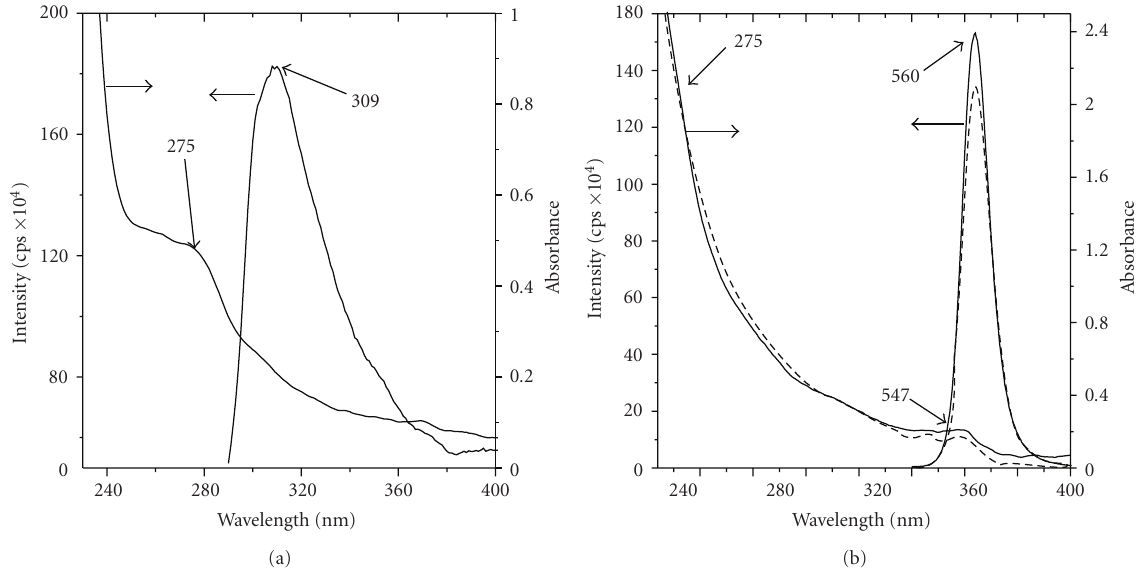
Figure 2: (a) UV-vis and fluorescence spectra of A β (1–42). Fluorescence spectrum was obtained using a quartz cell with an optical path length of 1cm, excitation wavelength at 280nm, and 5, 5nm slit width at the excitation and emission, respectively; (b) UV-vis and fluorescence spectra for A β (1–42) mixed (—) and conjugated ( ) to QDs. Fluorescence spectrum was obtained using a quartz cell with an optical path length of 1 cm, excitation wavelength at 467 nm, and 2, 2 nm slit width at the excitation and emission,